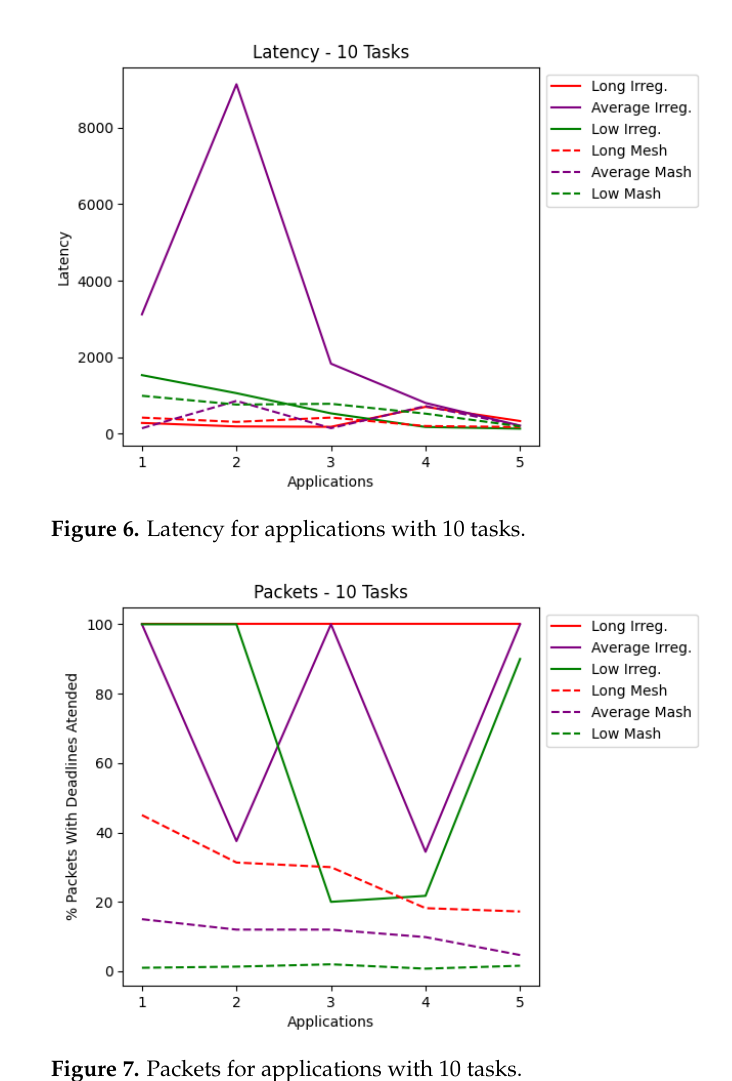
Figure 7. Packets for applications with 10 tasks.